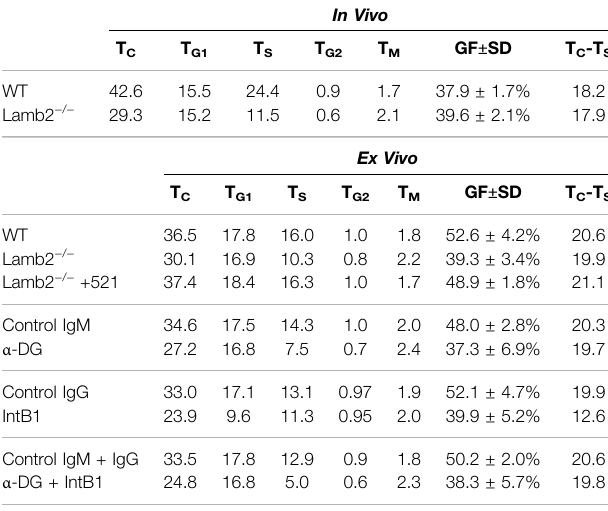
TABLE 1 | In vivo and ex vivo RPC cell cycle